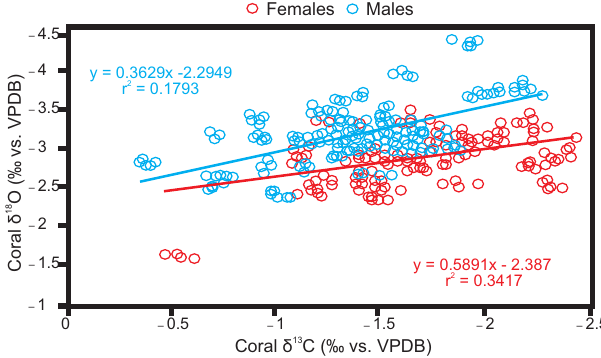
Figure 6. Plot of δ 13 C vs. δ 18 O of female (red dots), and male (blue dots) Porites panamensis coral from Bahía de La Paz. This includes all isotopic data of all colonies. Line equations and coefficients (red represents females; blue represents males) are